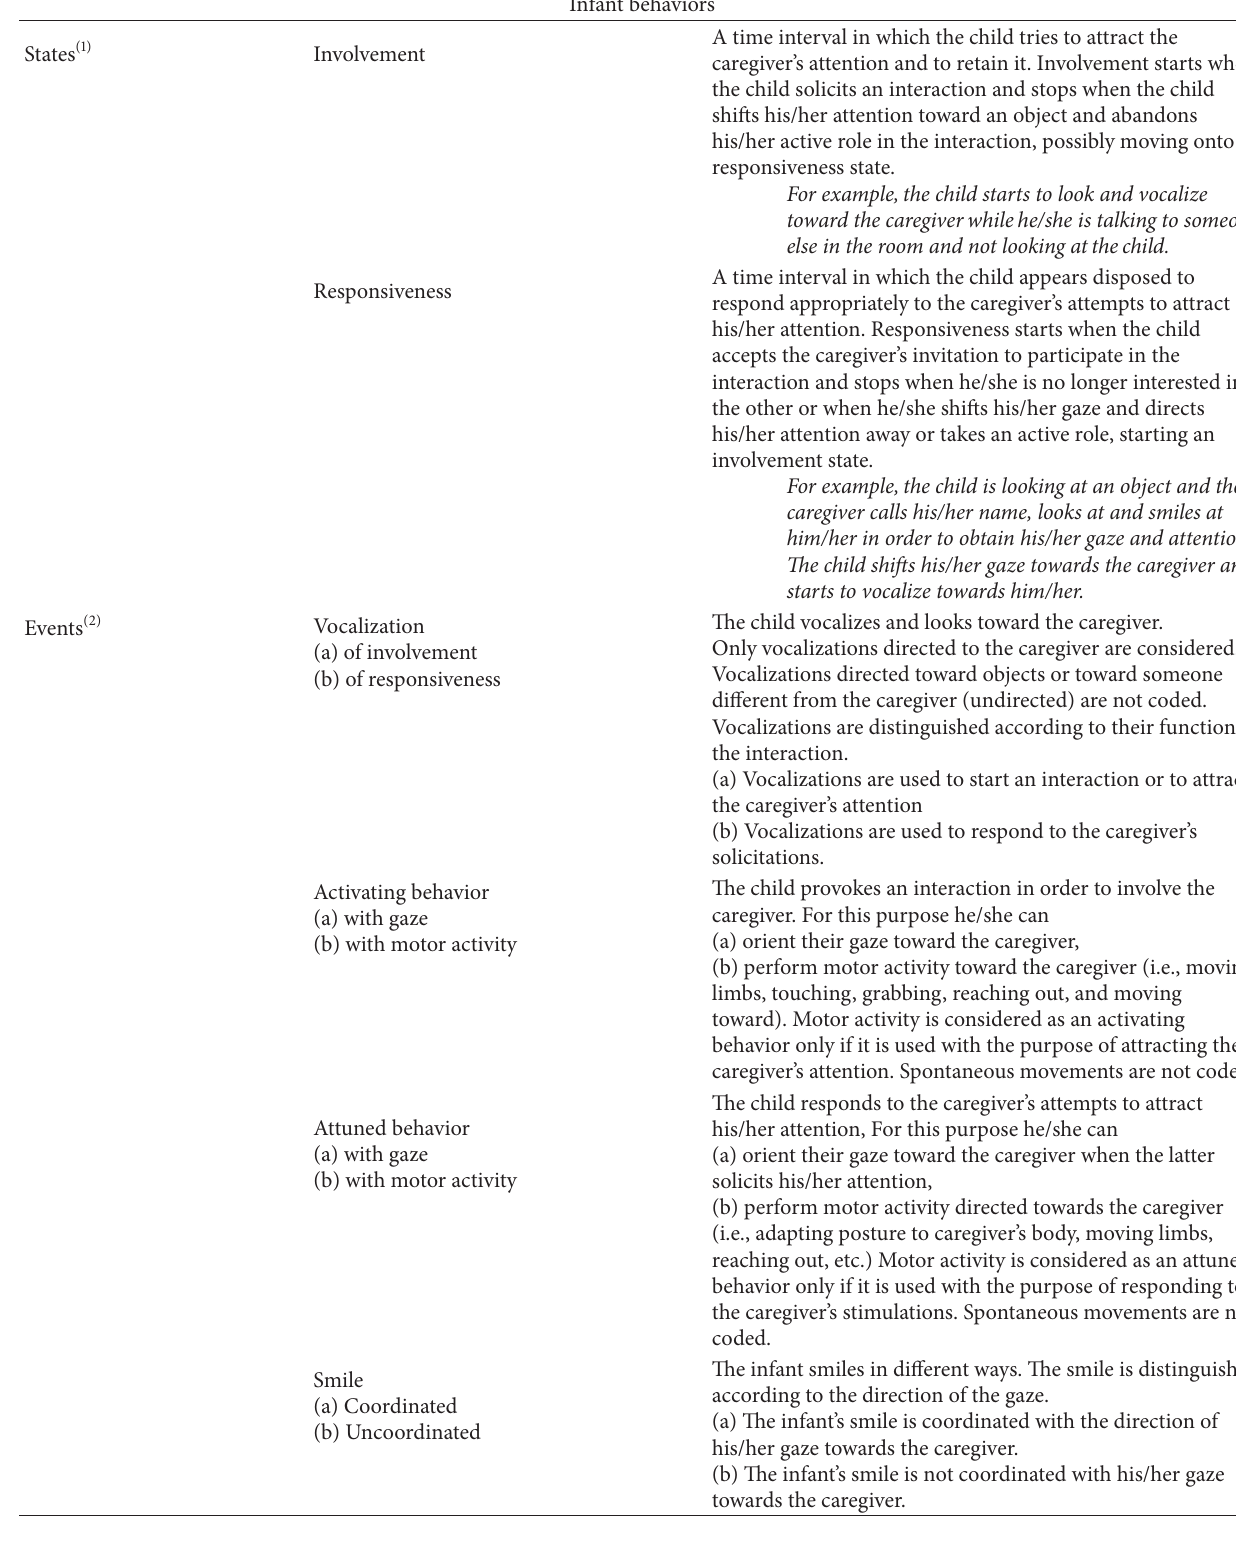
Table 1: Caregiver-infant rating